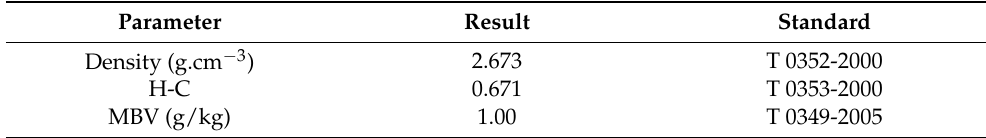
Table 3. Properties of the mineral